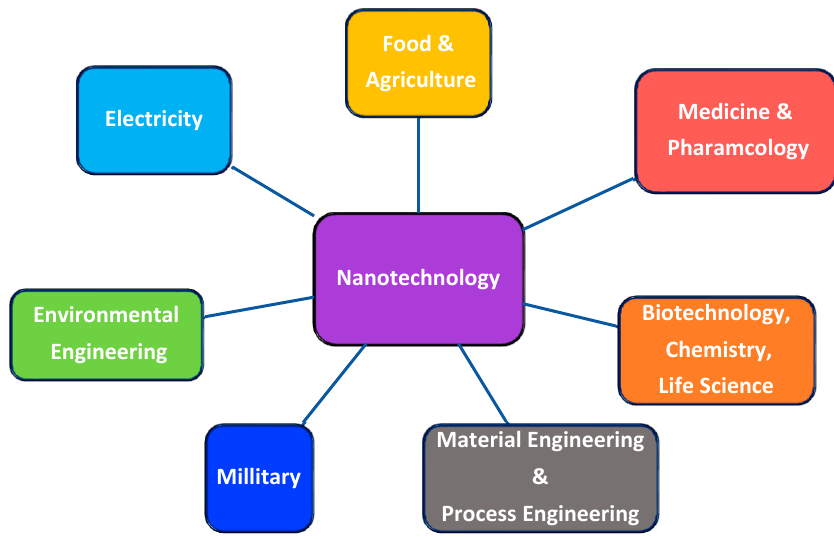
Figure 1. Overview of the different application fields of NTs.